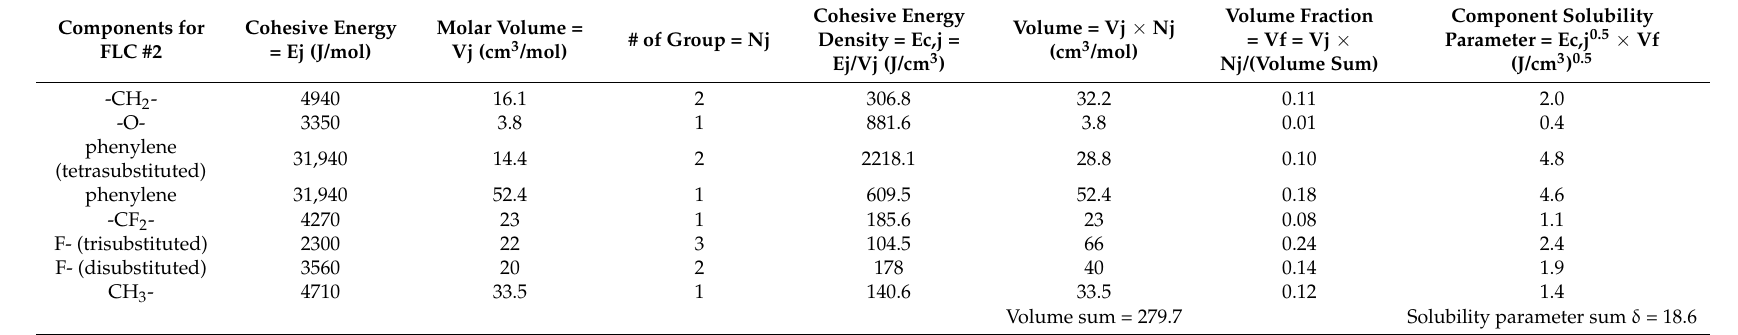
Table 8. Calculation process of the solubility parameter based on the molecular structure of